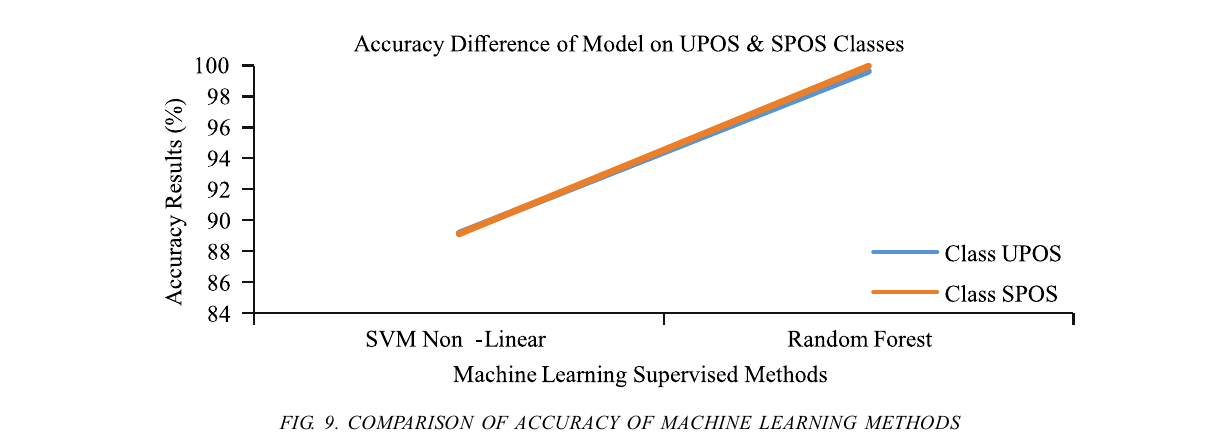
FIG. 9. COMPARISON OF ACCURACY OF MACHINE LEARNING